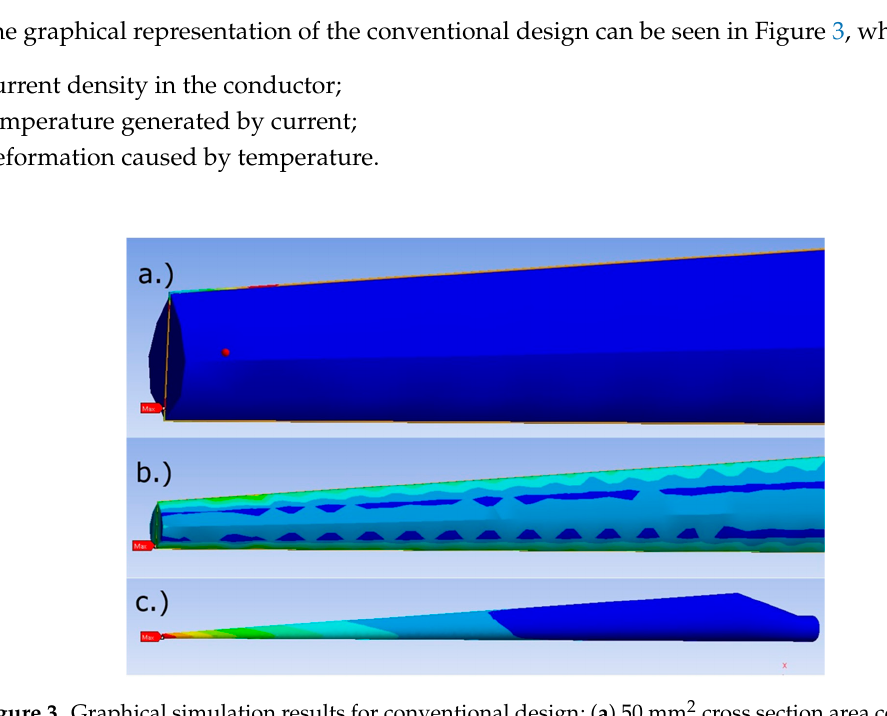
Figure 3. Graphical simulation results for conventional design; ( a ) 50 mm 2 cross section area conductor, ( b ) 100 mm 2 cross section area conductor; ( c ) 200 mm 2 cross section area